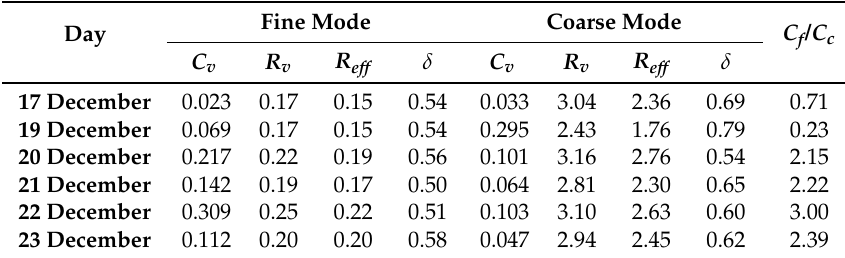
Table 1. Daily mean parameters of aerosol volume size distribution ( C v is volume concentration; R eff is effective radius; R v is volume median radius; δ is standard deviation). Fine Mode Coarse Mode C f / C Day